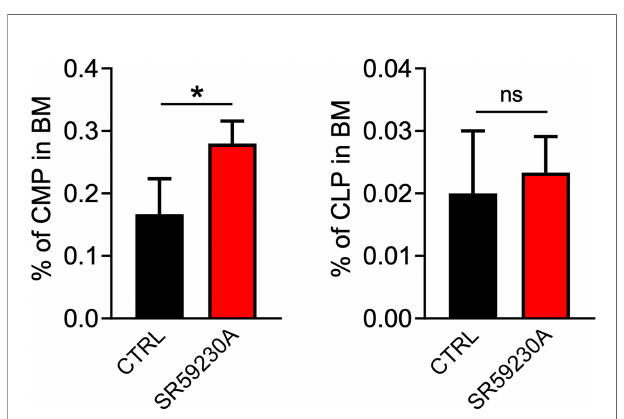
FIGURE 4 | Study of the b 3-AR antagonism effect on BM progenitor cells ( in vivo model as in Figure 1A ). Flow cytometry analysis was performed by using a MACSQuant Analyzer 10 (Miltenyi Bio-tec). CMP were identi fi ed as Lin - Sca1 - CD117 + CD16/32 - CD34 + , CLP as Lin - Sca1 low/int CD117 low/int CD127 + . Results were reported as the mean±SD of four replicates. *p <0,05 SR59230A vs. CTRL. ns, non signi fi